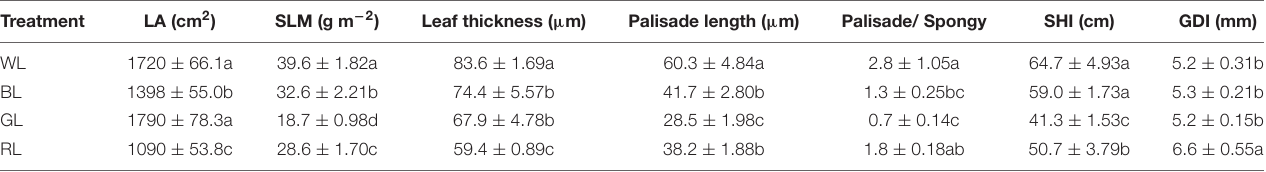
TABLE 2 | Effects of light quality on leaf area (LA), specific leaf mass per area (SLM), leaf thickness, palisade length, palisade/spongy ratio, seedling height increment (SHI), and ground diameter increment (GDI) in C. paliurus (Means ± SD).